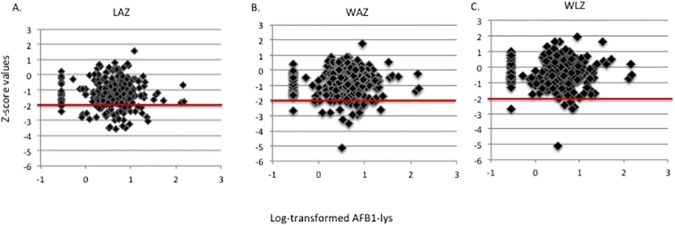
Serum Aflatoxin association with z-scores: Serum AFB1-lys level vs. A) LAZ, p = 0.9822; B) WAZ, p = 0.7024; and C) WLZ, p = 0.693. p-values represent those calculated for simple linear regressions. * Clustered points at AFB1-lys level of -0.4 represents subjects with AFB1-lys levels below the limit of detection. The red line delineates the mark of a z-score ≤ -2, the WHO cutoff for stunting, wasting, or underweight designation.